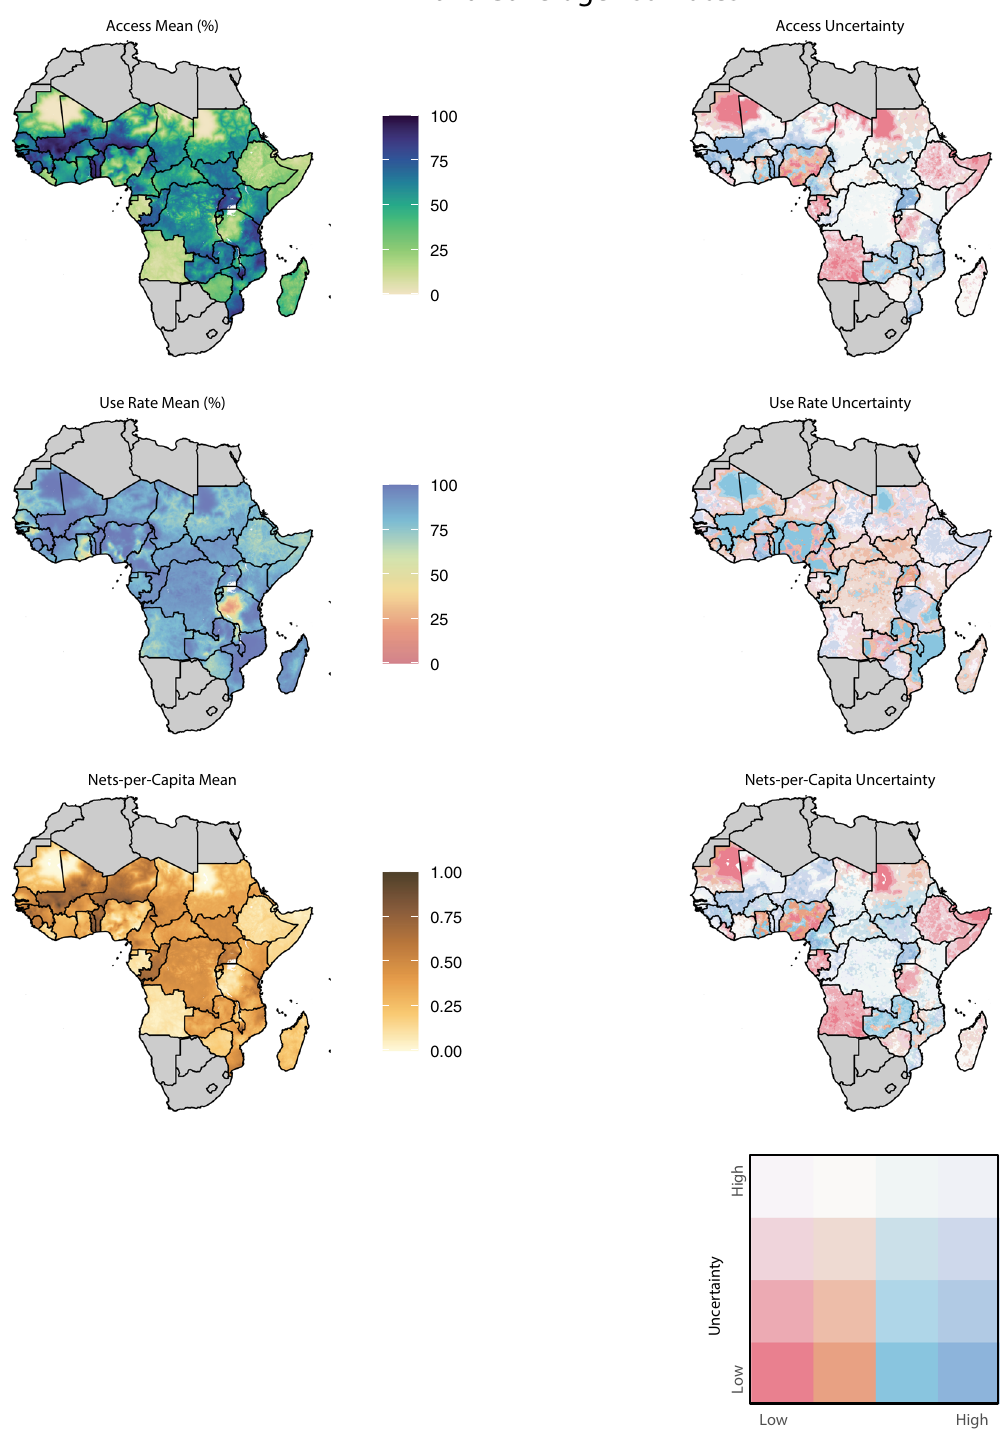
Fig. 3 Maps of insecticide-treated net access, use rate, and nets-per-capita (NPC) in 2020, with associated uncertainty. Access is de fi ned as the proportion of the population that could sleep under a net, assuming one net per two people. The use rate is de fi ned as use among those with access. The uncertainty maps use a bivariate scale to convey information about both mean estimates and magnitude of uncertainty. Quantiles of 95% con fi dence interval width are represented by saturation level, with the most uncertain values having the lowest saturation. Quantiles of mean values are represented by hue, with low values in pink and high values in dark blue. For example, access estimates are most uncertain in the Democratic Republic of the Congo and Zimbabwe in 2020, but there is considerable certainty that much of northern Mozambique is in the third quartile of use